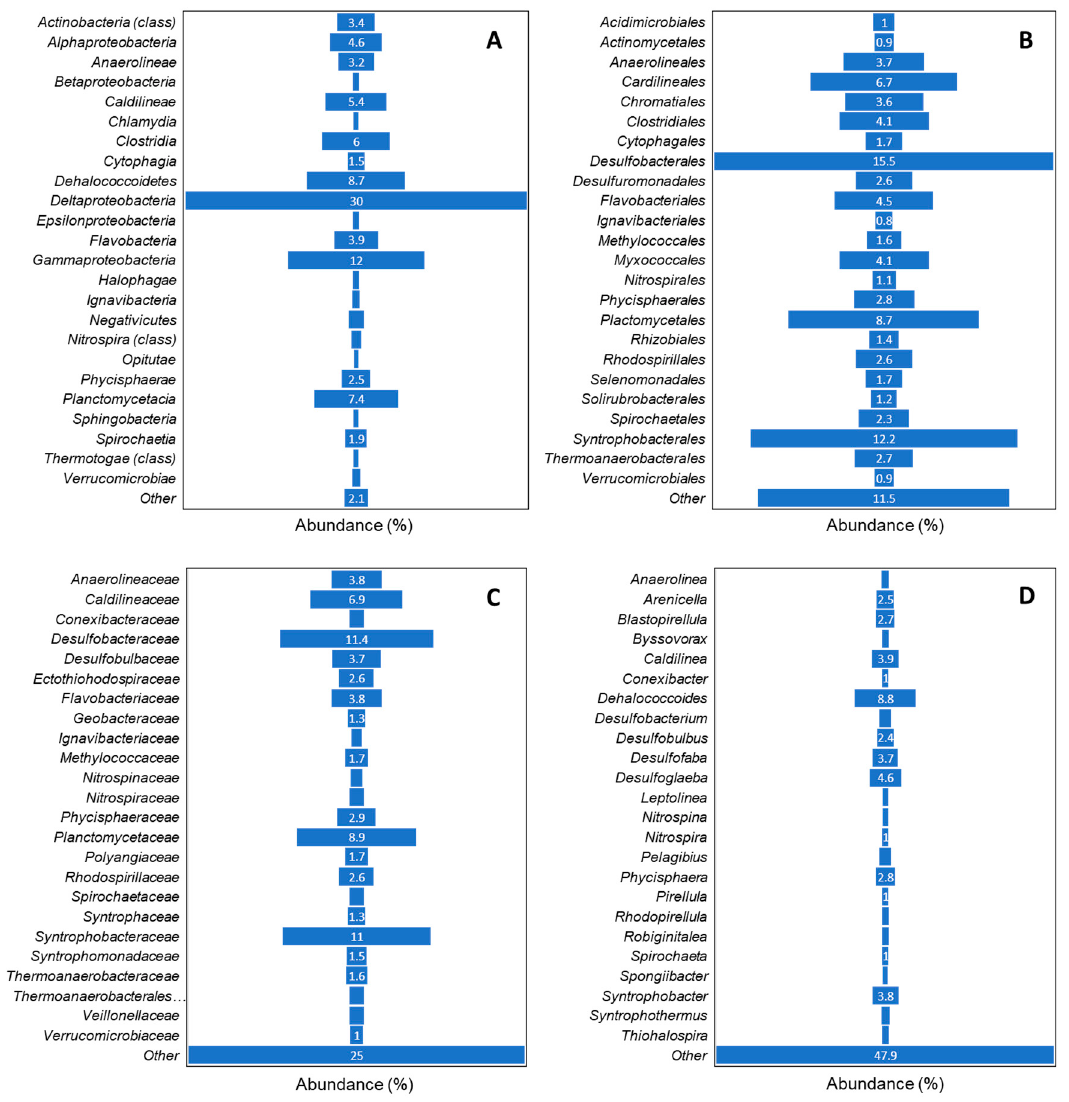
Figure 4. Taxonomic classification of bacterial communities in Moreton Bay sediment samples for 253 cohort ( A ) Class, ( B ) Order, ( C ) Family and ( D ) Genus. 254